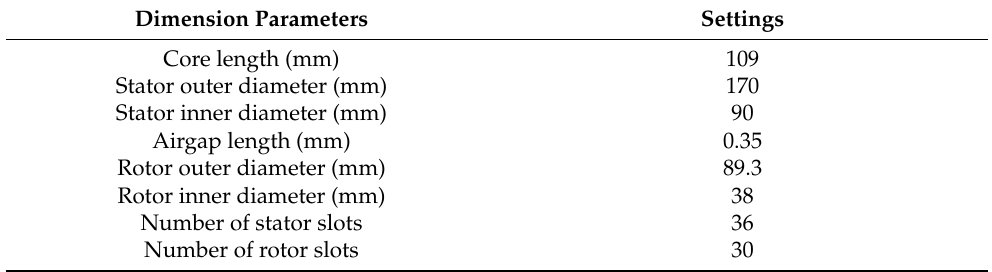
Table 2. Main dimensions of IM [9].